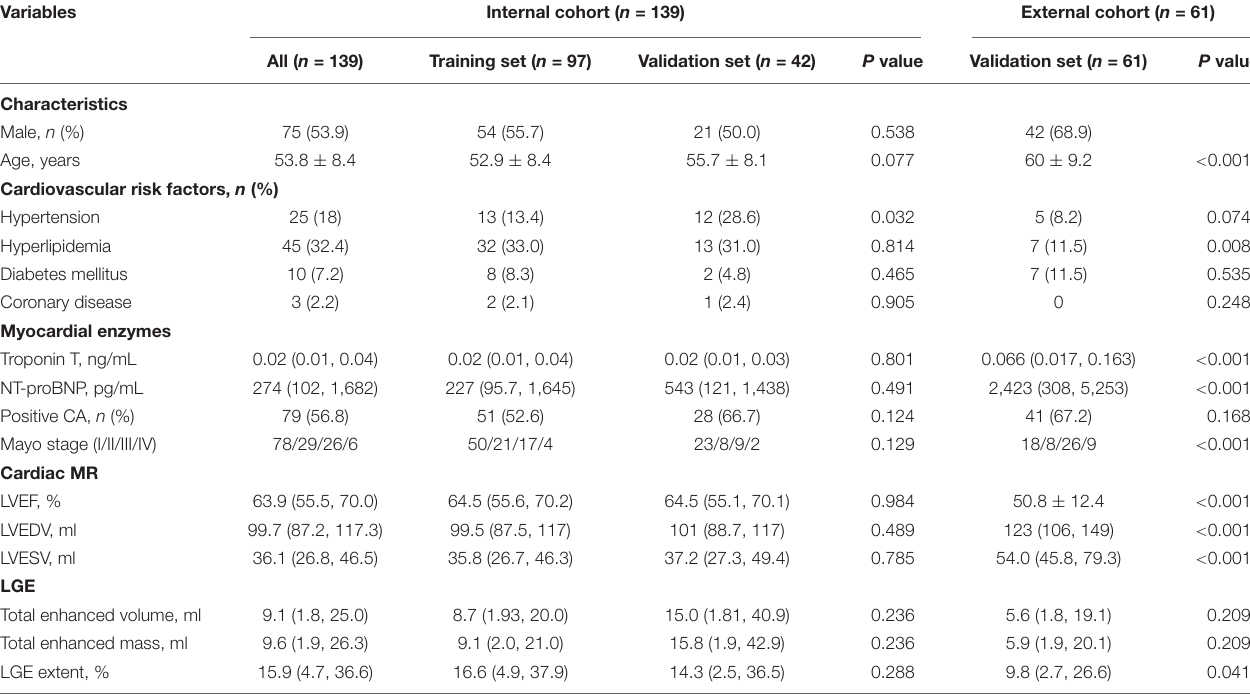
TABLE 1 | Clinical characteristics and cardiac magnetic resonance (CMR) data in the training and validation data sets. Variables Internal cohort ( n = 139) External cohort ( n = 61) All ( n = 139) Training set ( n = 97) Validation set ( n = 42) P value Validation set ( n = 61) P value